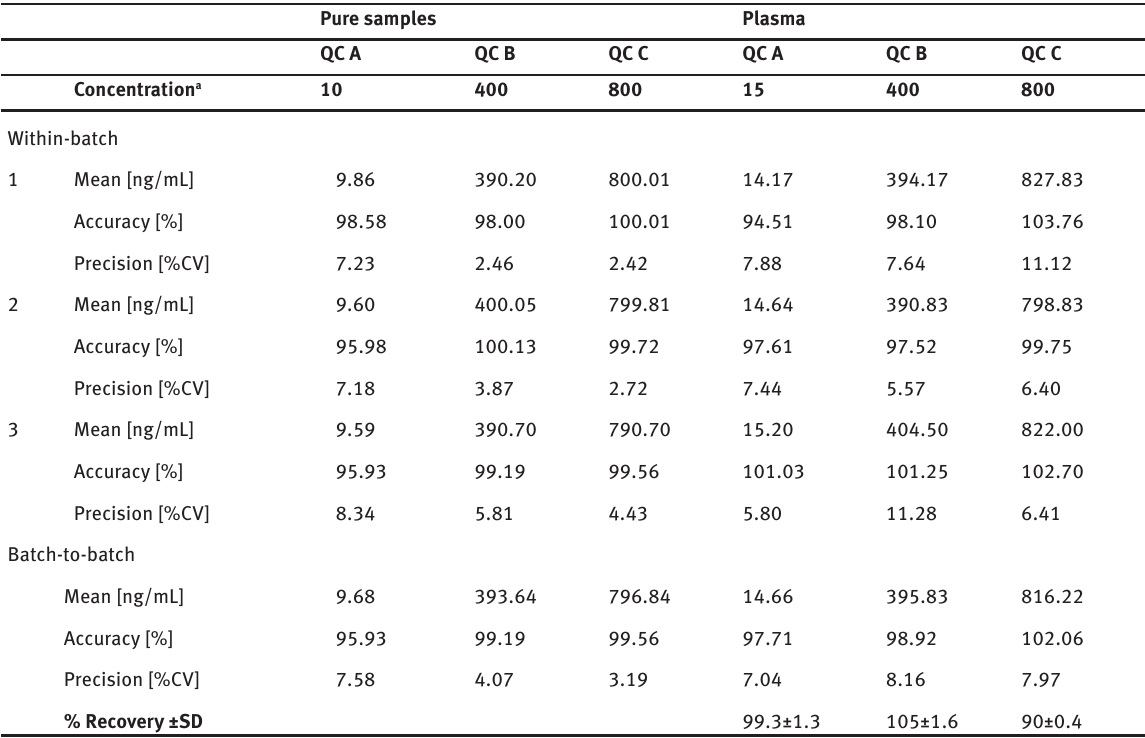
Table3: Validation results for DCV in pure form and plasma matrix with the extraction recovery percentage.